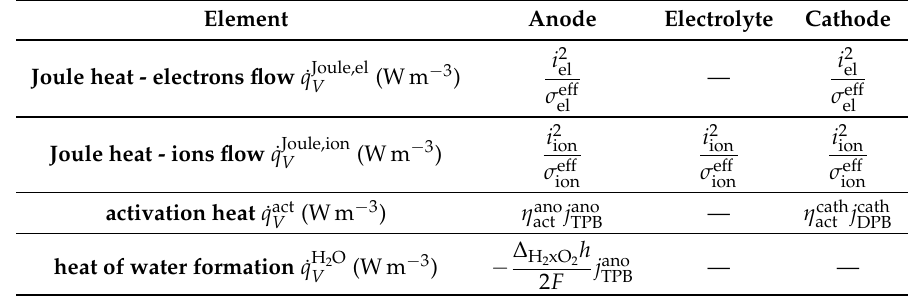
Table 11. Heat sources for Equation (19).